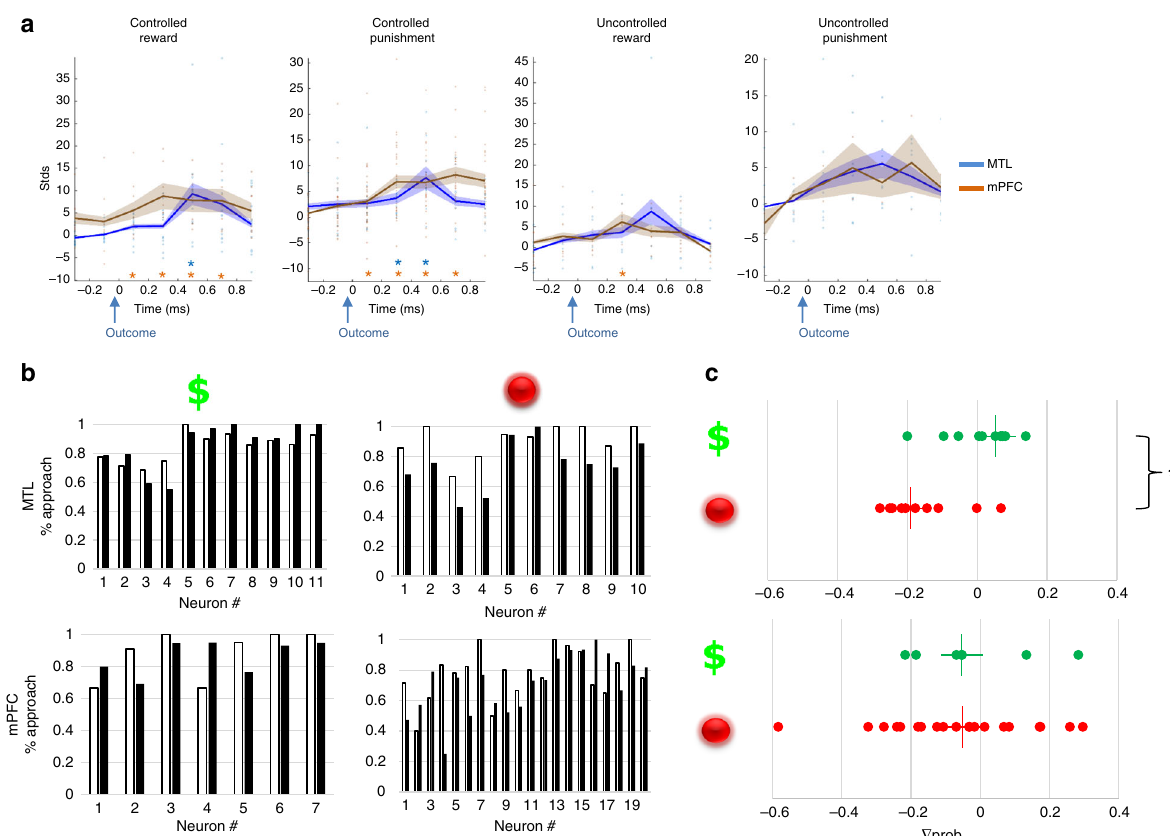
Fig. 5 Neural fi ring change and their effect on subsequent behavioral choice. a Time courses for mean normalized FR change in mPFC (brown trace) and MTL (blue trace) sites for each outcome type. Asterisks mark for which 200 ms window the FR is signi fi cantly above baseline (two-sided signed rank test, p < 0.05 FDR corrected, Control Reward N = 14 and 9 for MTL and mPFC, respectively). Control Punishment N = 12 and 29 for MTL and mPFC, respectively. Uncontrol Reward N = 8 and 8 for MTL and mPFC, respectively. Uncontrol Punishment N = 8 and 2 for MTL and mPFC, respectively. Note that for both controlled outcomes mPFC neurons fi re slightly before MTL neurons (left) but not for uncontrolled outcomes (right). Time 0 on the x -axis represents the timing of outcome (coin or ball hit the avatar). Shaded area corresponds to SEM. Source data are provided as a Source Data fi le. b , c The effect of neural responses following controlled outcomes on subsequent behavioral choice under HGC condition. b The mean probability for approaching a coin, subsequent to trials where a neuron fi red 200 – 800 ms following a controlled outcome (black bars) vs. trials where a neuron did not fi re (white bars), shown for MTL ( b , top) and mPFC ( b , bottom) neuron groups per outcome type. Note that only MTL neuron showed a consistent pattern of subsequent behavior of less approach after punishment outcome ( b , top right). c Approach probability change following neural fi ring to controlled rewards (green markers) and controlled punishments (red markers) in MTL ( c , top) and mPFC ( c , bottom). c (top) Asterisk denotes a signi fi cant two-sided Mann –